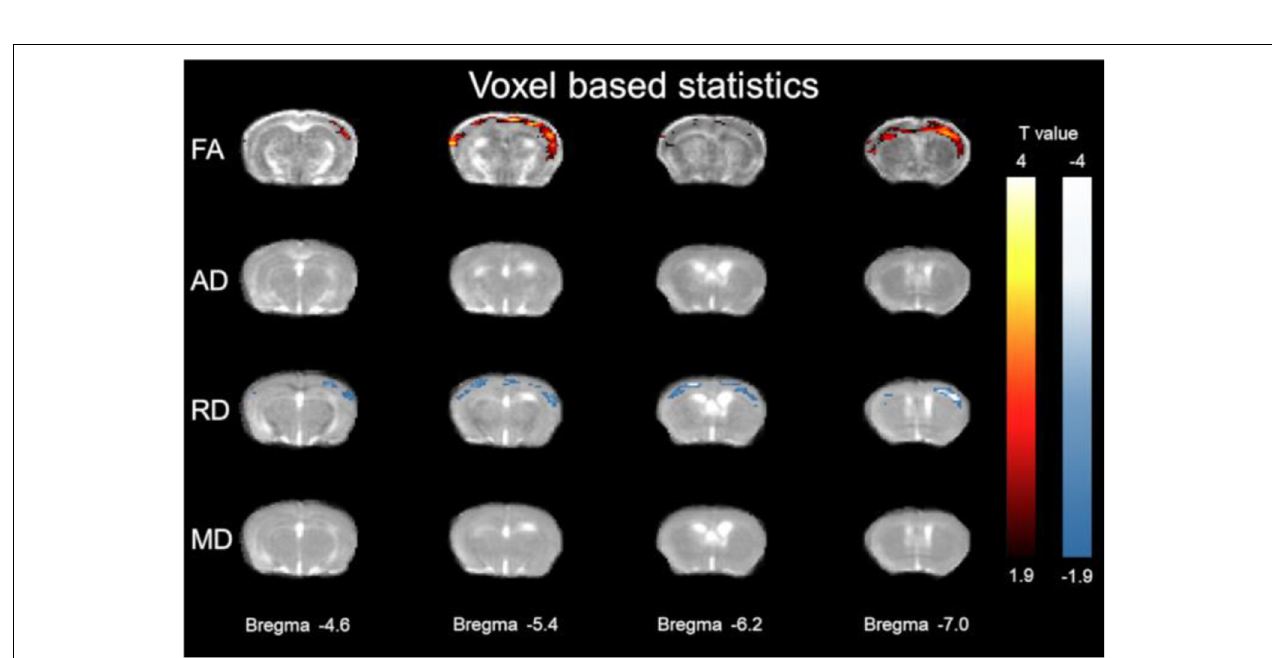
FIGURE 2 | Voxel based statistics of cortex. The y -axis representing rows are FA, (AD λ //), (RD λ ⊥ ), and MD. Columns represent different Bregma locations − 4.6, − 5.4, − 6.2, − 7.0. Color bars represent positive t value differences (warm colors from 4 to 1.9) and negative t value differences (cool colors from − 4 to − 1.9).